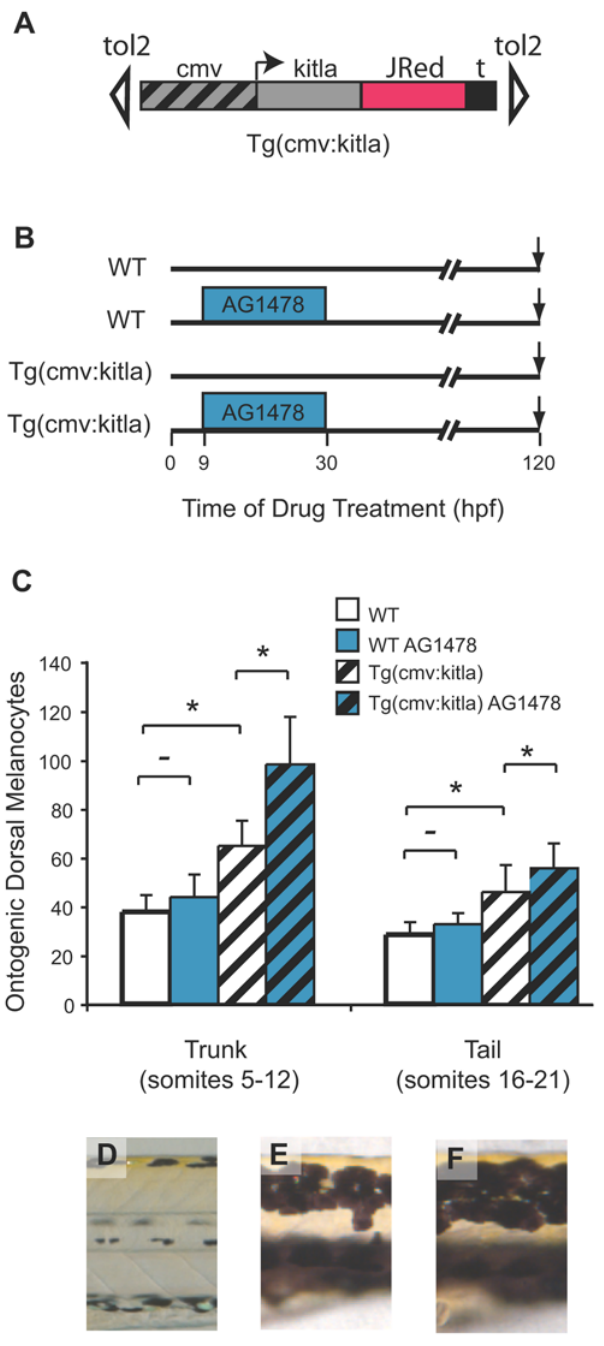
Figure 7. kitla melanocyte proliferation is enhanced by AG1478. (A) Cartoon of the PT2hsp70:kitla construct in transgenic animals. The constitutive cmv promoter drives expression of kitla . (B) Schematic of drug treatment timeline with early treatment of AG1478. (C) Quantitation of average ontogenetic dorsal melanocytes for each treatment in (A) in the trunk (somites 5–12) and in the tail (somites 16– 21). Error bars represent standard deviation, * P , 0.05, - P . 0.05 (Student t-test, N=10). As reported previously (see Figure 1) WT larvae show no effect in ontogenetic melanocyte number with AG1478 treatment compared to untreated WT. PT2hsp70:kitla animals have significantly more melanocytes in both the trunk and the tail. Treating PT2hsp70:kitla animals with AG1478 early, from 9–30 hpf, produces a significantly greater number of melanocytes in the trunk. In contrast, the tail region of AG1478-treated PT2hsp70:kitla larvae shows